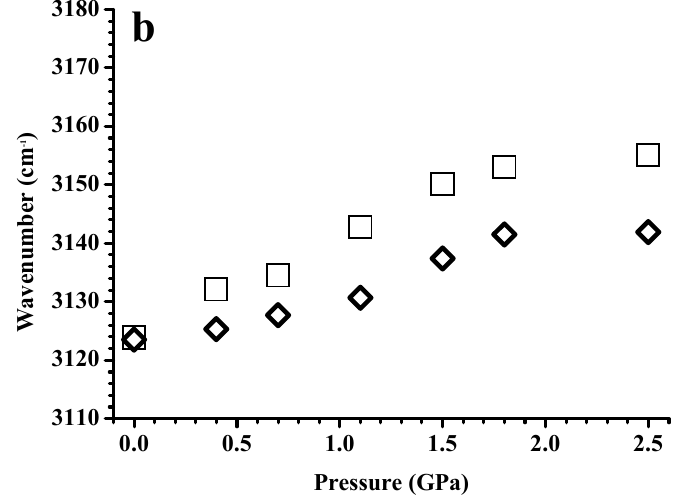
Figure 4. Pressure dependence of the C–H stretching frequencies at ( a ) 3164 and ( b ) 3124 cm − 1 of the pure [C 2 C 1 Im][BF 4 ] (squares) and [C 2 C 1 Im][BF 4 ] in a silica matrix (diamonds).